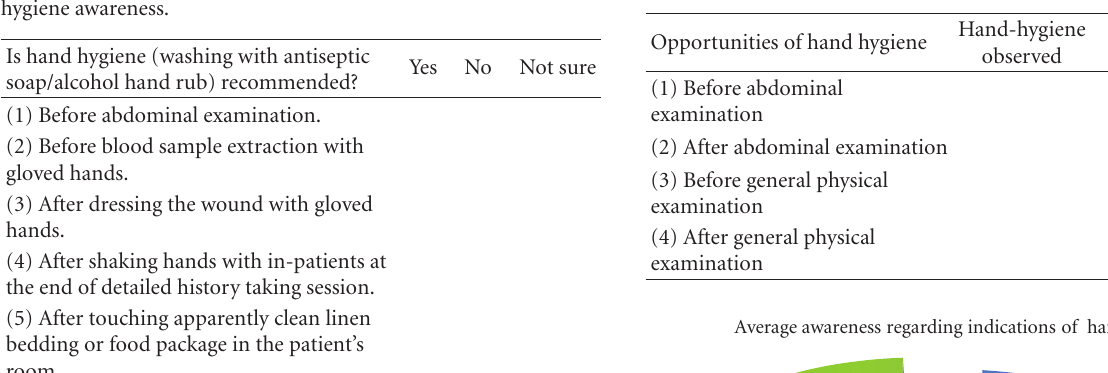
Table 2: Scenarios used for assessment of hand hygiene compliance.